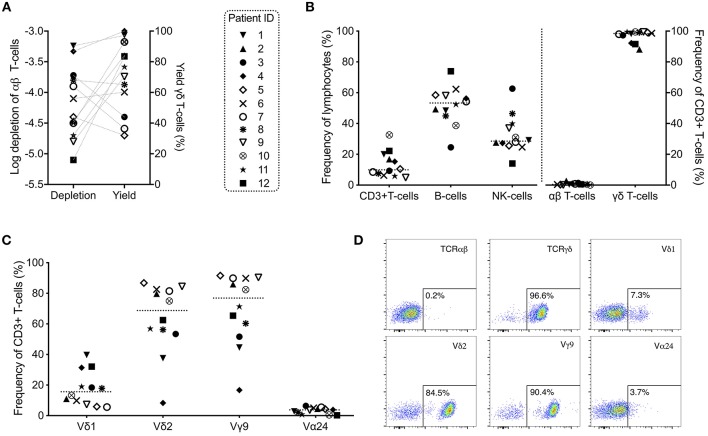
Characteristics of αβ T-cell depleted grafts used as stem cell boosters (n = 12). (A) Log depletion of αβ T-cells and yield (recovery) of γδ T-cells in target fractions infused into patients (connected with dashed lines). (B) Analysis of cell subsets of interest in the αβ T-cell depleted cell products with (C) more detailed analysis of γδ subsets and invariant NKT-cells post-depletion gated on total T-cells. (D) Representative example plots of T-cells with αβ T-cell receptor (TCR), γδ TCR and γδ subsets are shown from patient 9 (all plots gated on total CD3+ T-cells).